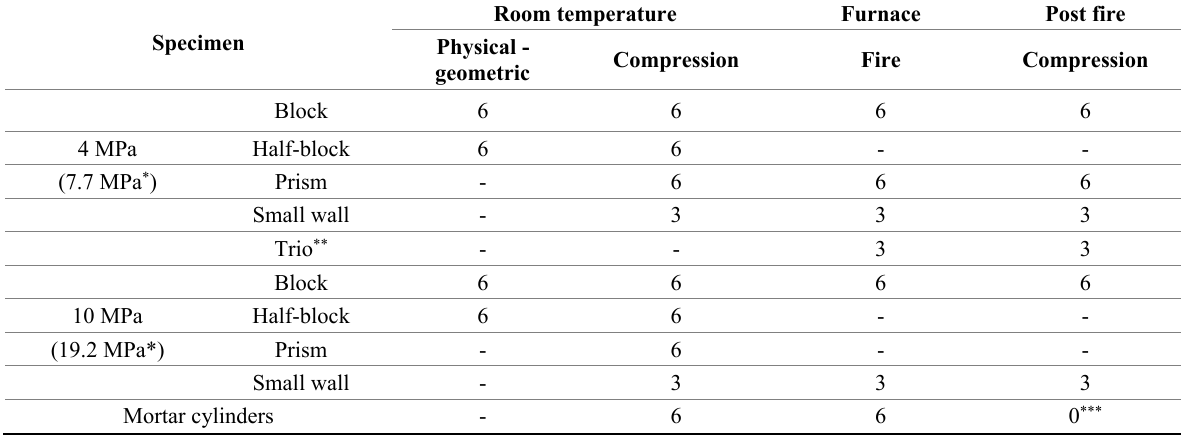
Table 1. Sampling and tests.